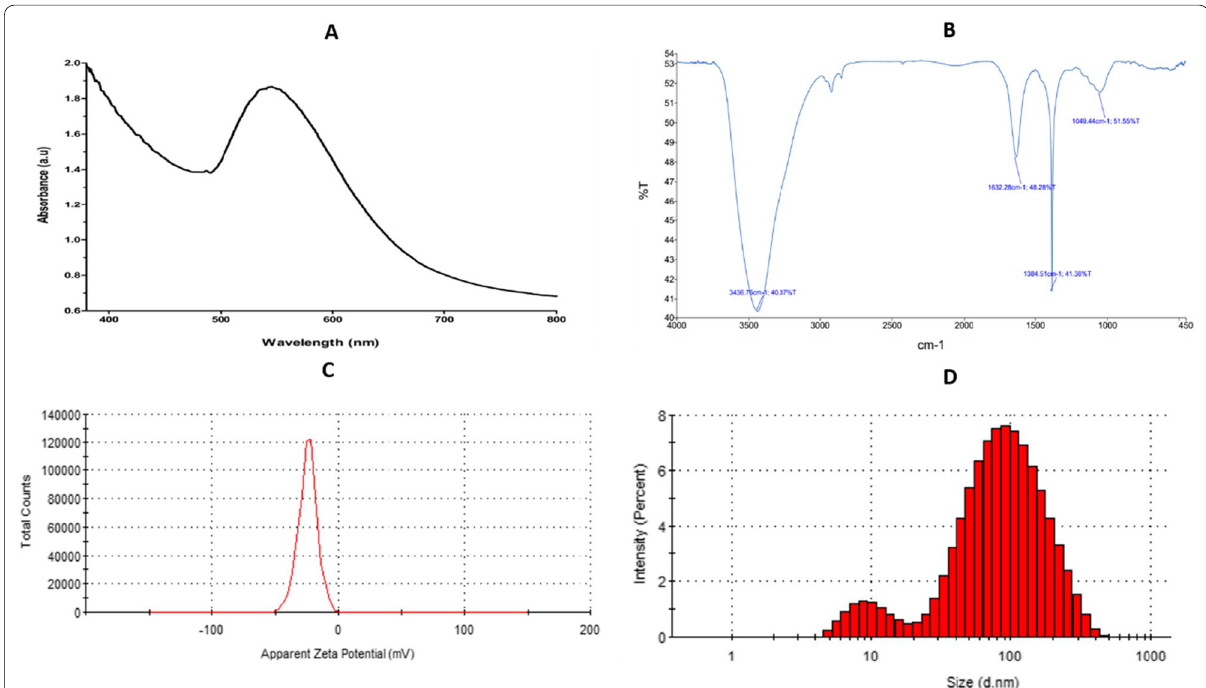
Fig. 2 Various characterization techniques for Au@AgNPs. A UV–vis spectrum, B FTIR, C the zeta‑potential diagram, and D DLS